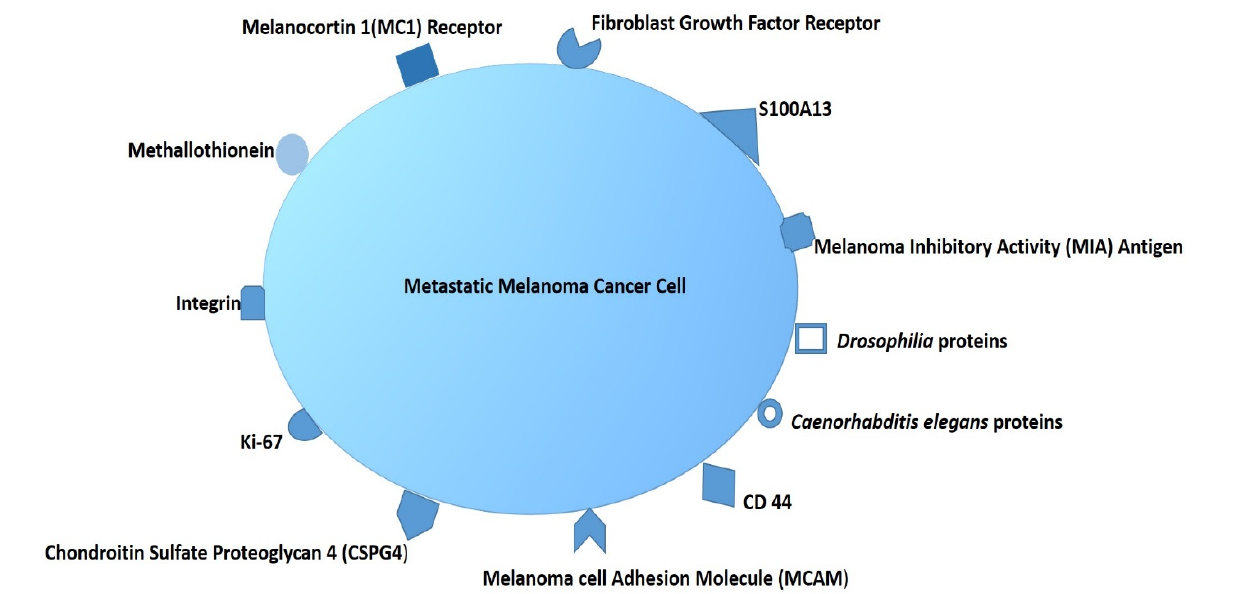
Figure 4. An overview of common antigens expressed by melanoma cells. Table 4. Metastatic melanoma active targeting delivery